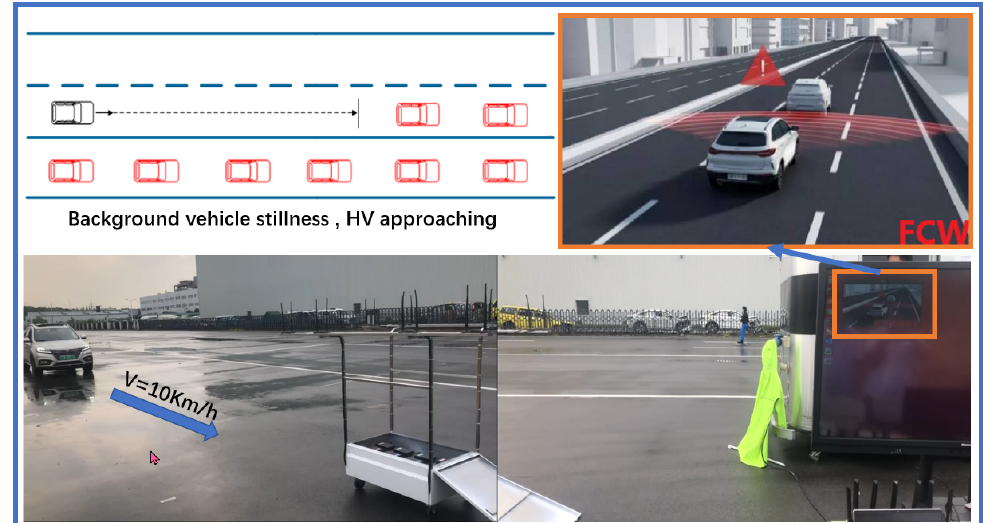
Figure 21. Outdoor Large-scale Test with HV and BOBUs.